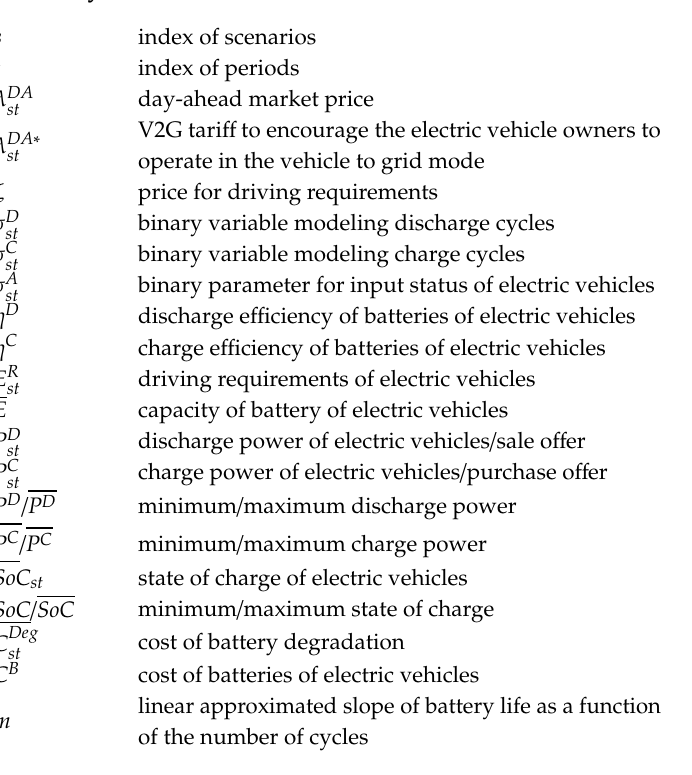
Table A1. Scenarios of driving requirements ( E R Hour \